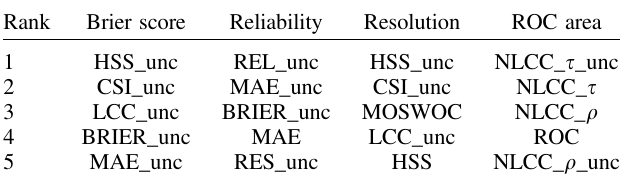
Table C.1. Rankings of evaluation metrics for X-class fl are forecasts. For each metric,the top fi ve performing ensembles are